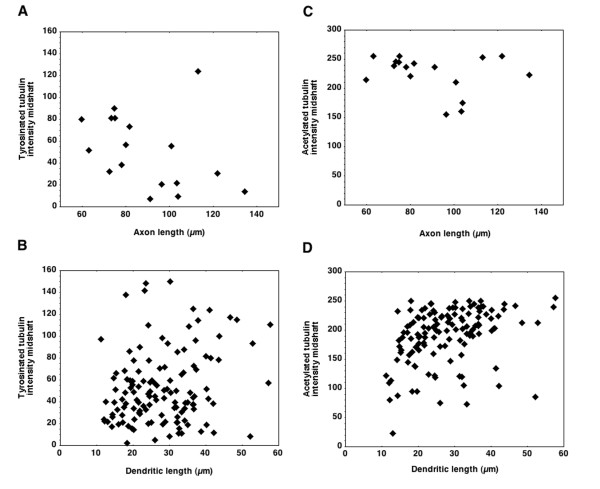
Relationship between fluorescence intensity (in arbitrary units) of Tyr-tubulin and Ac-tubulin at the mid-shaft and process length in 2-DIV neurons. (A) Intensity of Tyr-tubulin plotted against total axon length suggests an inverse relationship between length and amount of dynamic microtubules in the shaft, as predicted from previous work. (B) A plot of Tyr-tubulin and dendrite length does not show the same relationship. (C, D) Measures of Ac-tubulin in axons (C) and dendrites (D) are not suggestive of a linear relationship either. n = 16 neurons.